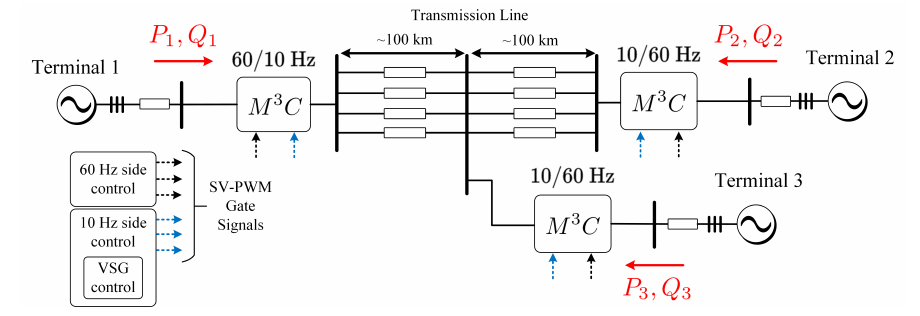
Figure 19. Multi-terminal LFAC system. Based on